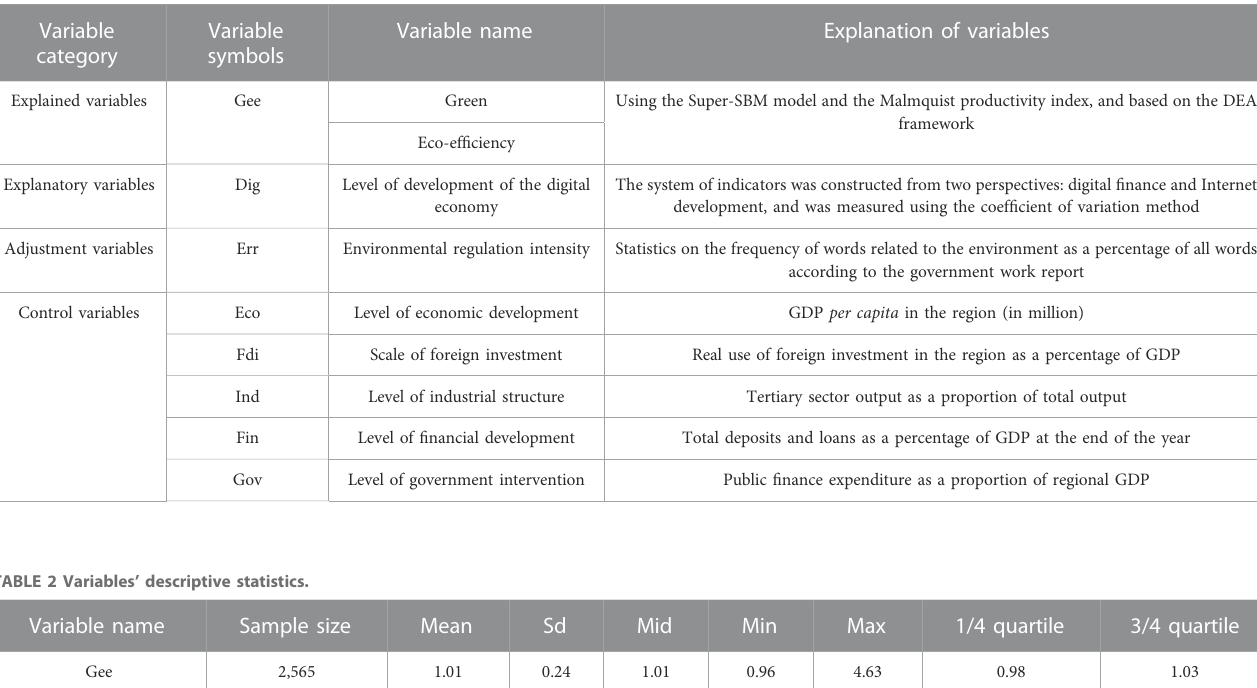
TABLE 1 De fi nition and interpretation of variables.